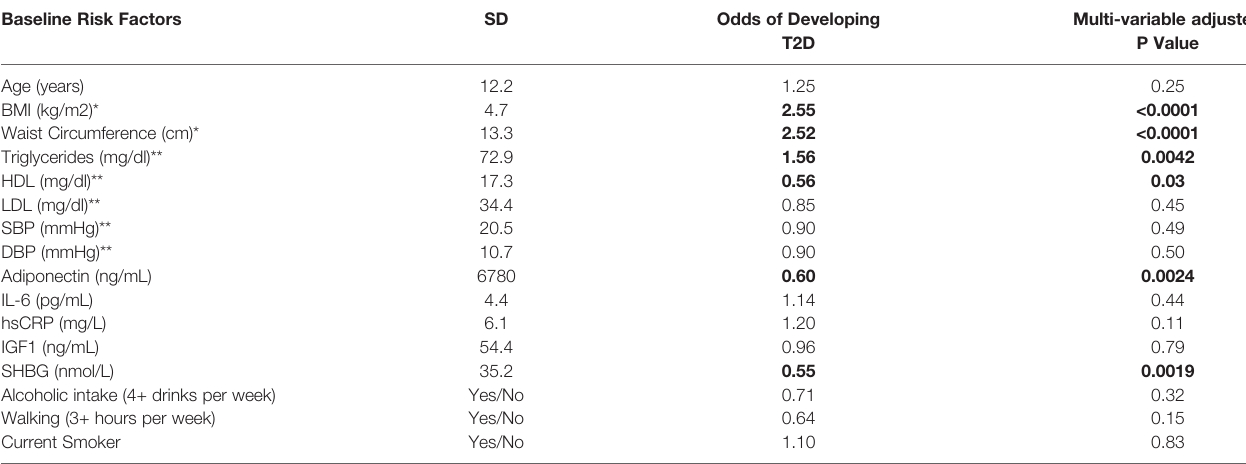
TABLE 2 | Risk factors for incident T2D in LLFS offspring + .